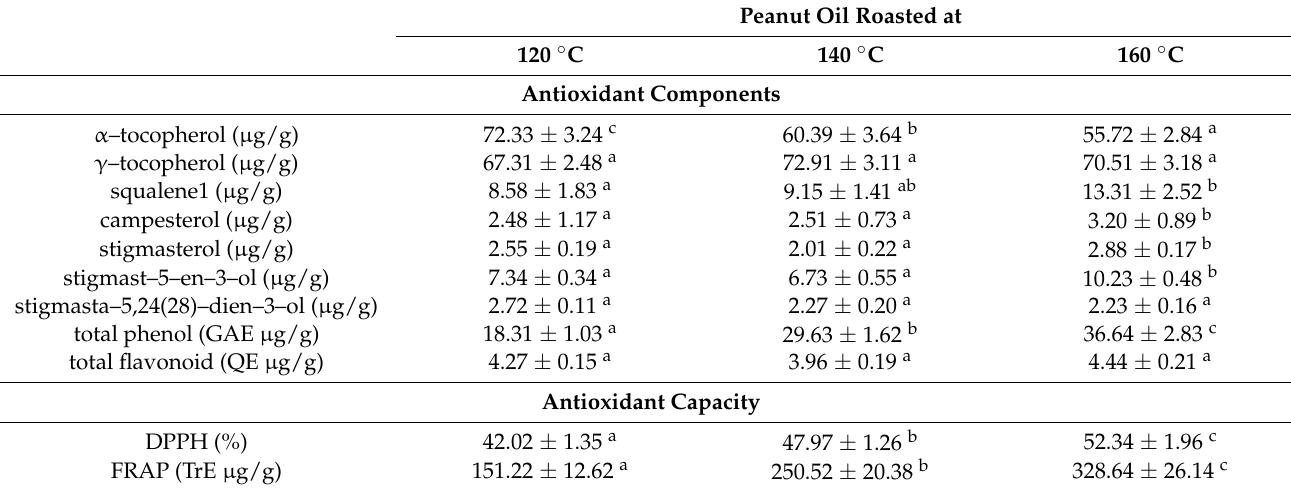
Table 3. Antioxidant components and antioxidant capacity in peanut oils was influenced by roasting